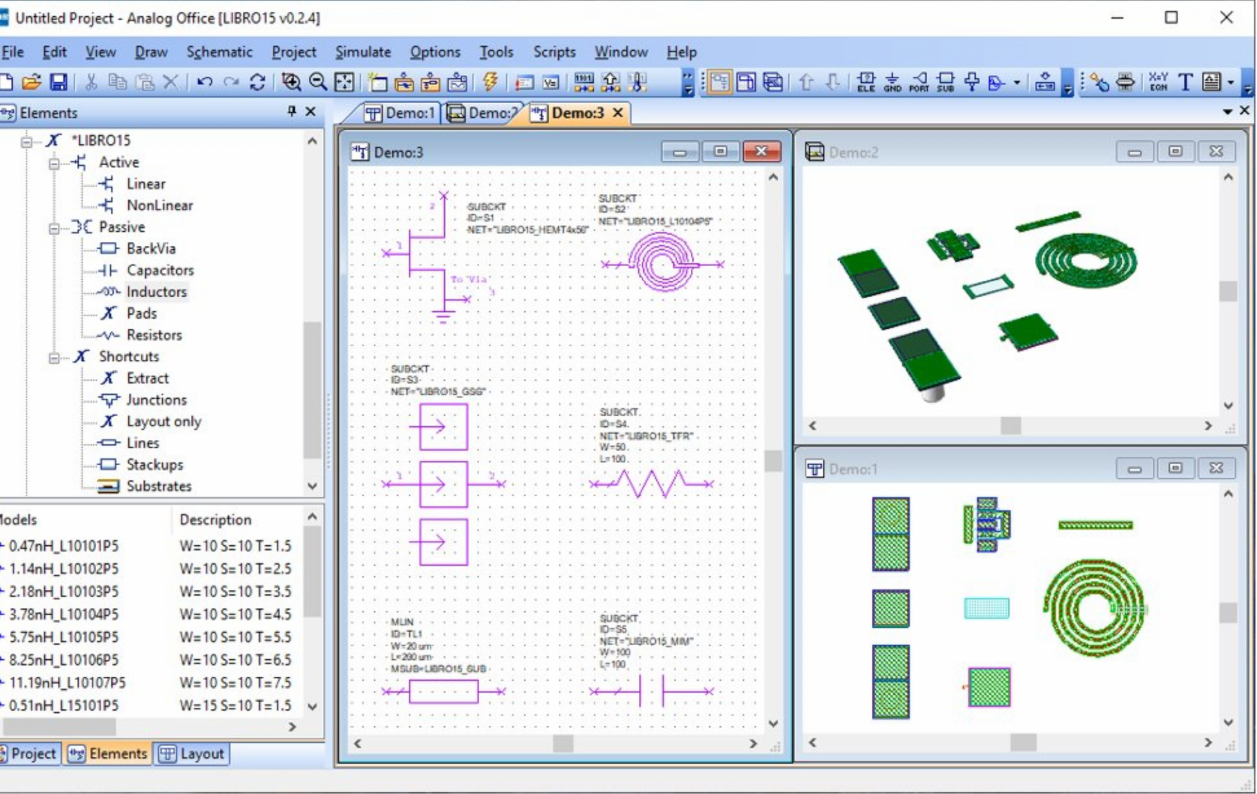
Figure 9. Several windows in AWR Microwave Office showing different aspects of the developed PDK in